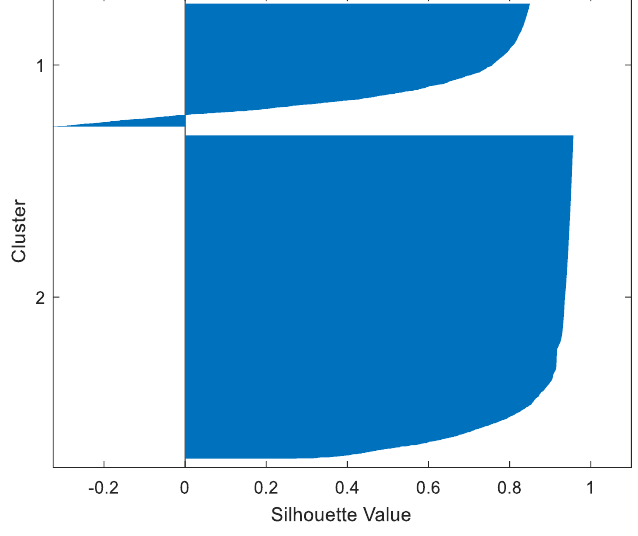
Figure 18. MAGIC FP-Conv-CM.